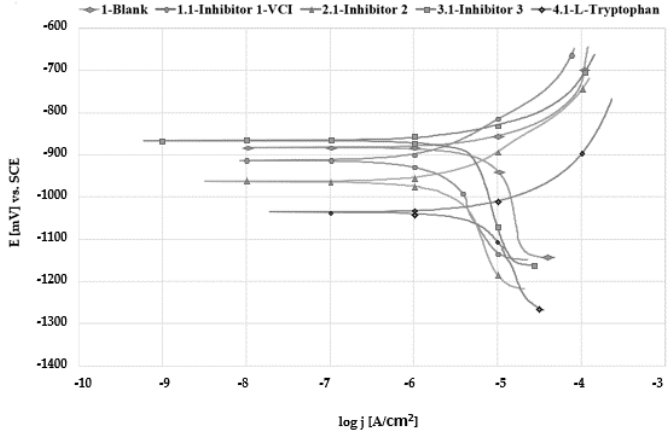
Figure 4. Polarization curves of tested inhibitors, compared to unprotected galvanized steel in fresh water.